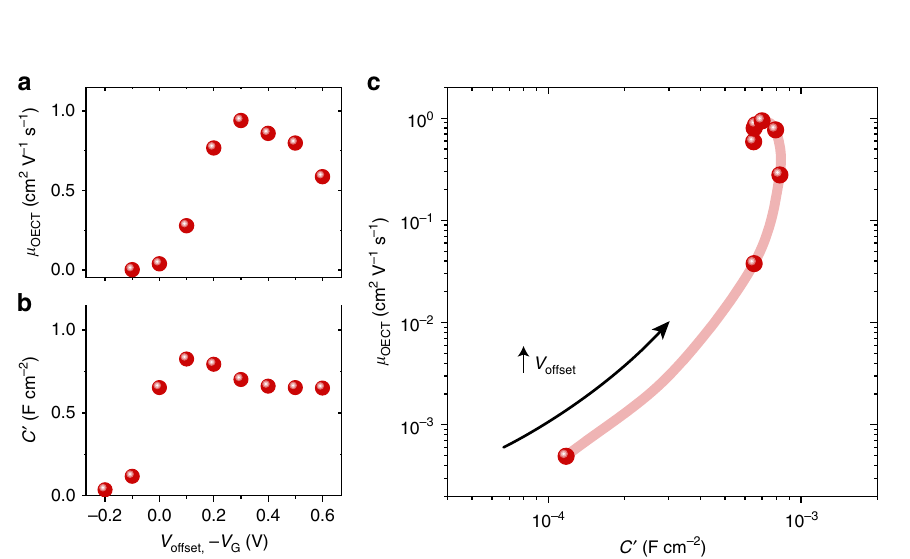
Fig. 3 Gate or offset bias trajectory for the p(g2T-TT). OECT mobility a and C ′ (capacitance per unit area) b as a function of bias ( V offset of working electrode for C ′ , − V G for μ ). c µ -C ′ map of data from a , b showing an example of a bias